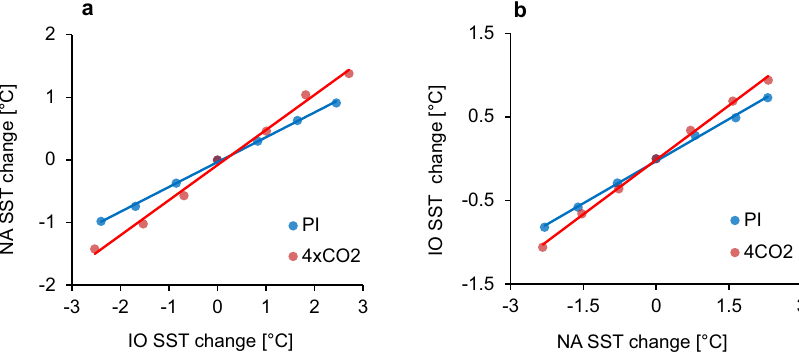
Fig. 4 Indian Ocean (IO) - North Atlantic Ocean (NA) warming trends derived from preindustrial and greenhouse warming simulations. a Changes of NA index versus changes of IO index and ( b ) observed NA SST anomalies in different preindustrial (PI) and quadruple CO 2 (4CO 2 ) experiments. The NA SST change is de fi ned by the difference of the NA index between the PI simulation with observed SST anomalies and that with relatively 1 °C uniformly warmer SST over the IO. The blue (red) line shows the corresponding linear regression curve. Each circle represents data from one experiment averaged for 100